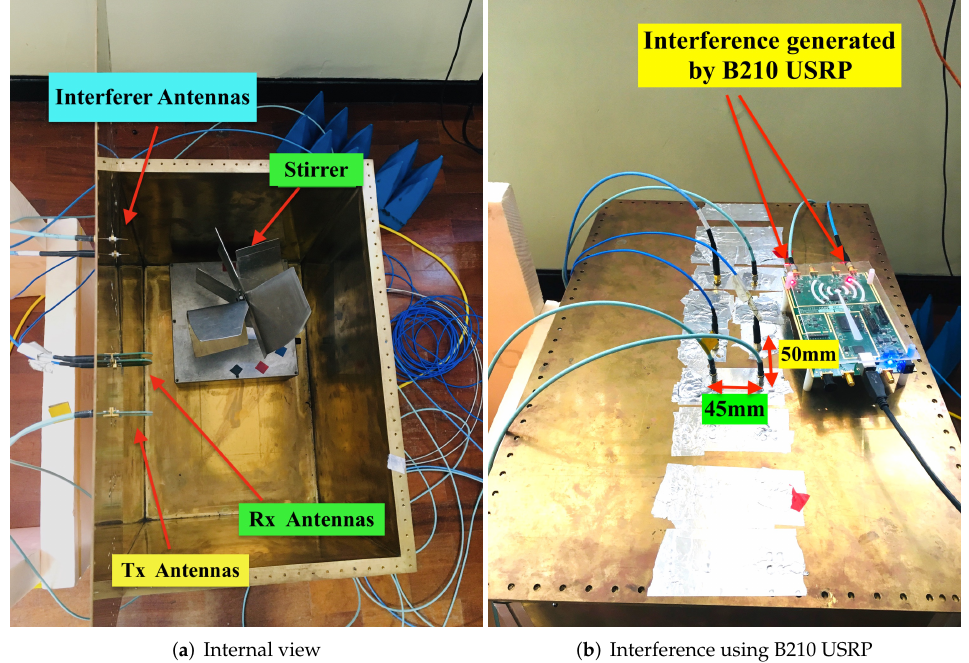
Figure 6. The 2 × 2 MIMO BER and EVM measurement setup in the presence of the MIMO